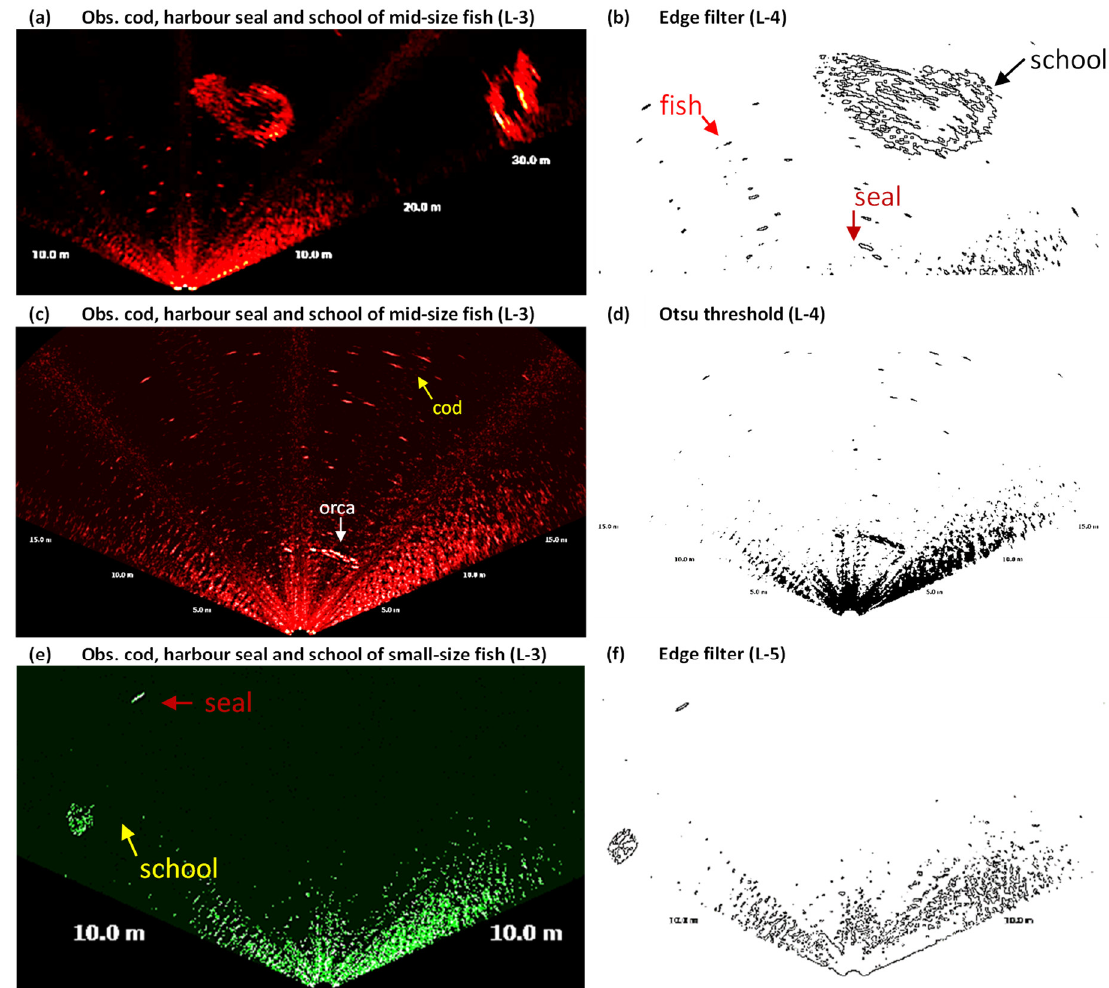
Figure 9. Visual signatures of fish, seals and orcas in simultaneous occurrence. ( a ) Acoustic image of cod, harbour seals and school of mid-size fish; ( b ) Shapes of harbour seals, cod and school of mid-size fish processed with edge filter. ( c ) Cod and an orca, and ( d ) shapes of cod, and orca processed with binary threshold; ( e ) School of small-size fish (“sprat”), and grey seals, and the respective shapes ( f ) processed using edge filter.